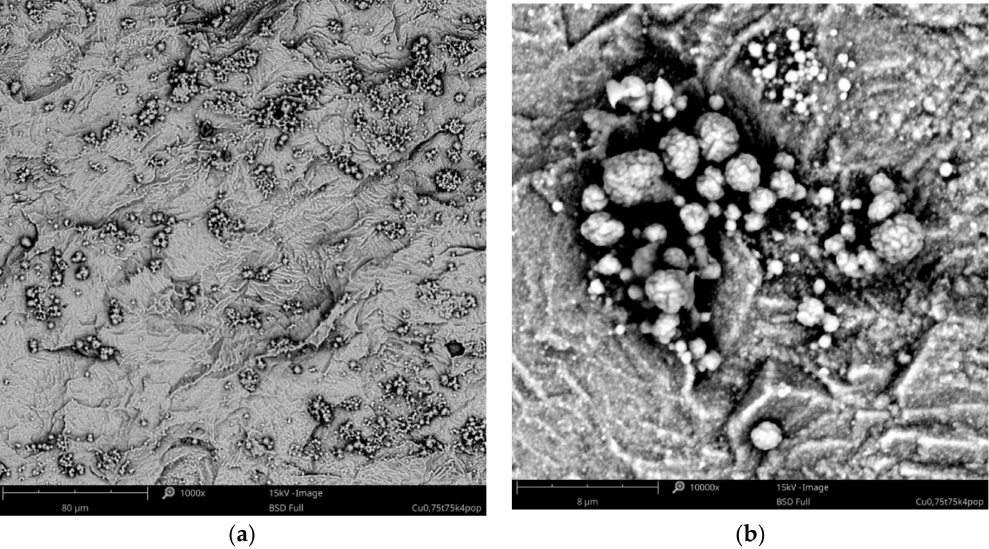
Figure 1. SEM images of Cu island electrodeposited in the bath with 20 g · L –1 of CuAc at a temperature of 75 ◦ C (j c = 0.75 mA · cm − 2 , t = 1 h) at low ( a ) and high ( b ) magnification.